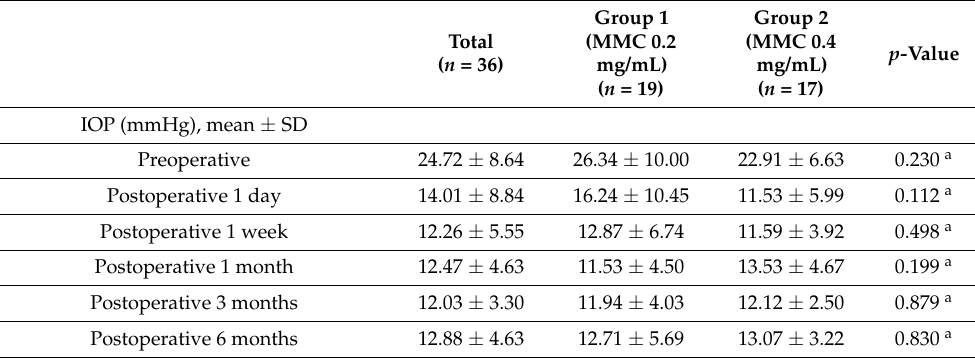
Table 2. Comparison of intraocular pressure and number of glaucoma medications between MMC 0.2 mg/mL group and MMC 0.4 mg/mL